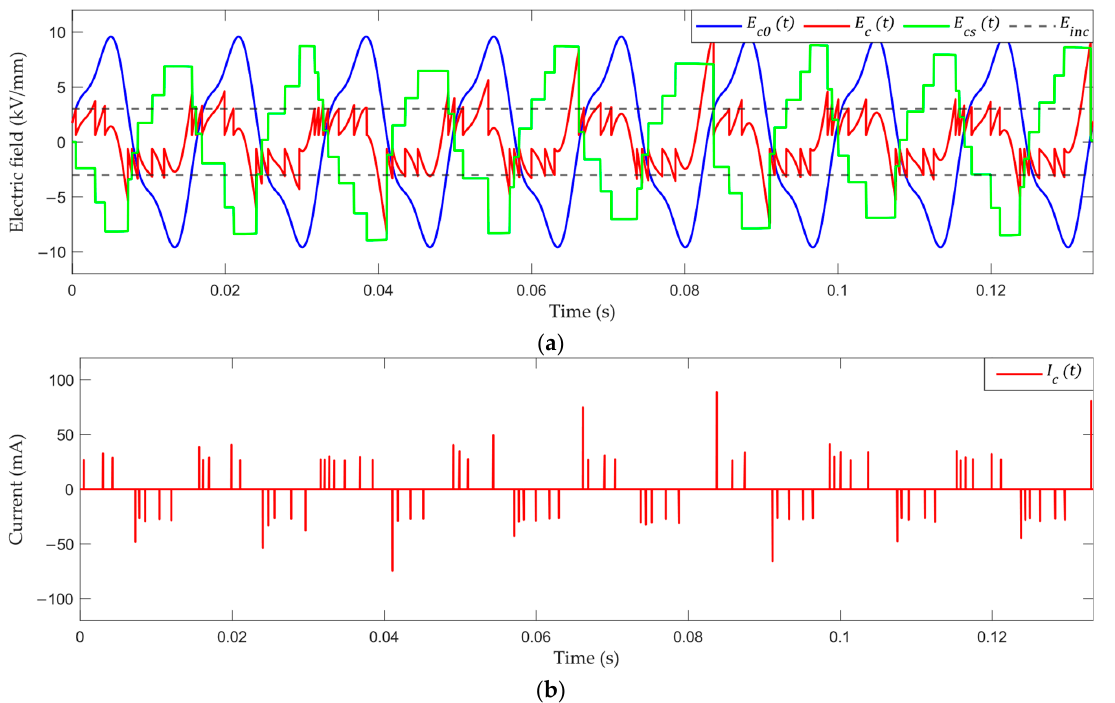
Figure 13. Simulated results for the case wherein a voltage distorted by the 3rd harmonic component with ϕ h = 90 ◦ and THD = 20% was applied: ( a ) electric fields over time; ( b ) PDs current pulses.